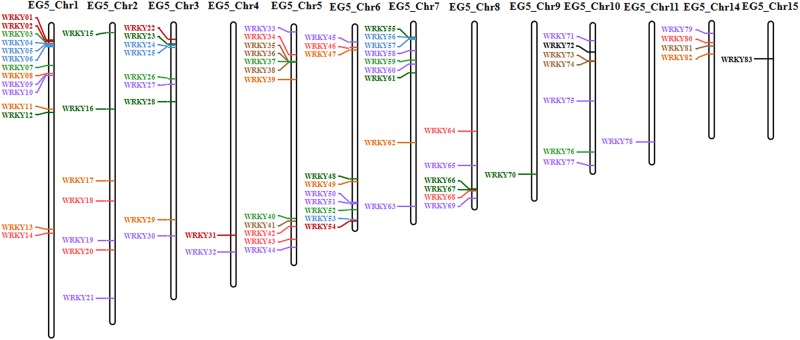
Distribution of EgWRKY genes across the chromosomes of Elaeis guineensis.Vertical bars represent chromosomes of Elaeis guineensis. The chromosome number is indicated at the top of each chromosome. The coloured lines indicate different clusters based on multiple alignments between conserved WRKY domains from the 95 EgWRKY genes identified in this study. Dark red: cluster I; Green: cluster II; Blue: cluster III; Yellow: cluster IV; Red: cluster V; Black: cluster VI; Purple: cluster VII; Brown: cluster VIII; Bright green: cluster IX.